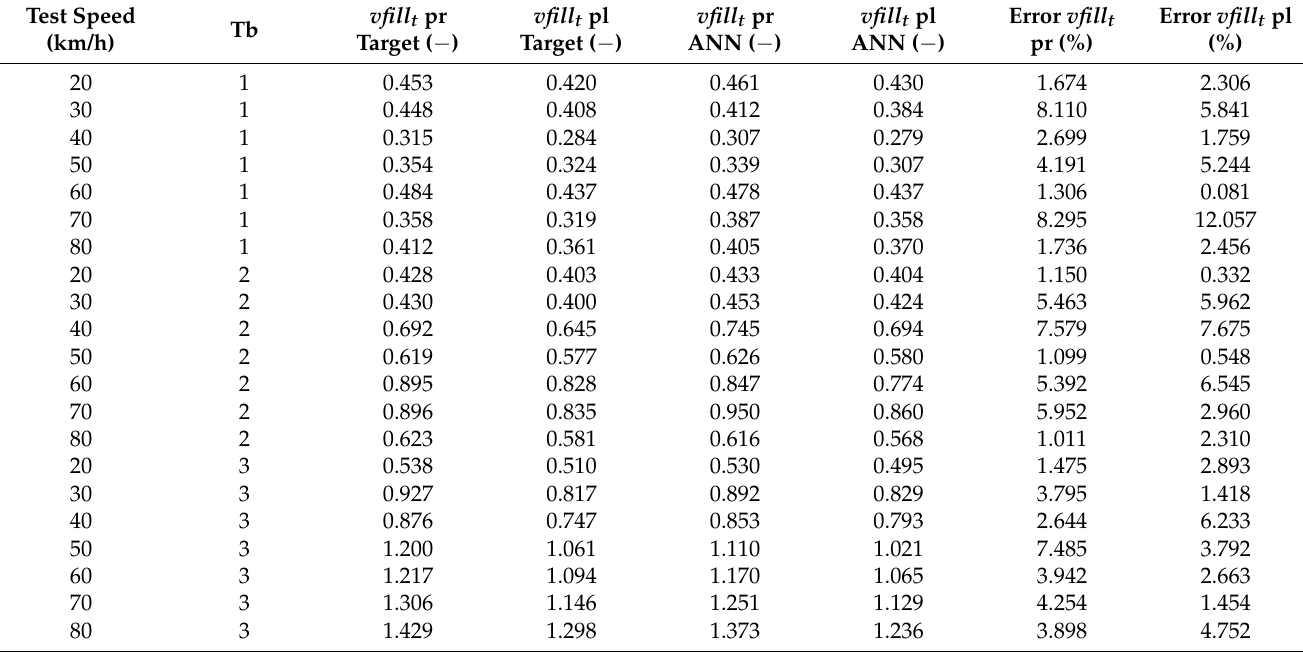
Table 6. Target and simulated values of vfill t of the right pressure sensor (pr), vfill t of the left pressure sensor (pl) and